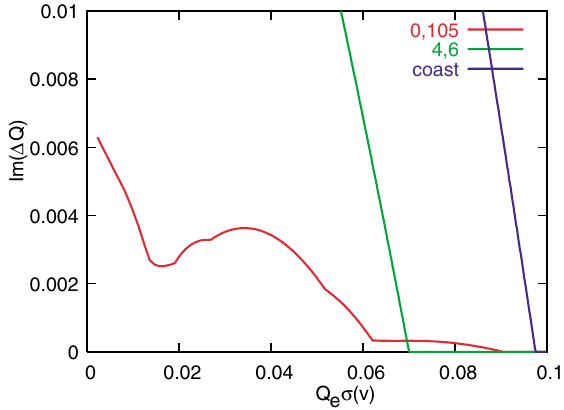
FIG. 12. (Color) Growth rate versus frequency spread for a simple model. The red and green traces are solutions to Eq. (22) with the (cid:3) 0 ; 1(cid:4) summation limits on p replaced by (0105) and (4,6), respectively. The blue trace is the coasting beam threshold from Eq.